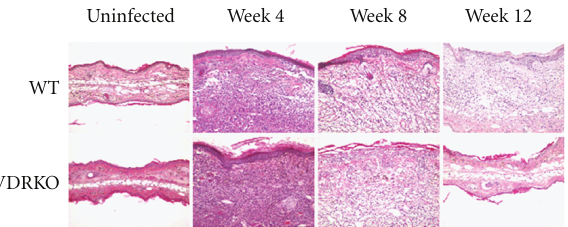
Figure 4: Inflammation is decreased in the infected ears of VDRKO mice. C57BL/6 WT and VDRKO were infected in the ear with 10 5 L. major parasites. Histological cross sections were H&E stained at the indicated time points and inflammation of the dermis was assessed visually by microscopy. One representative of 2 independent experiments is